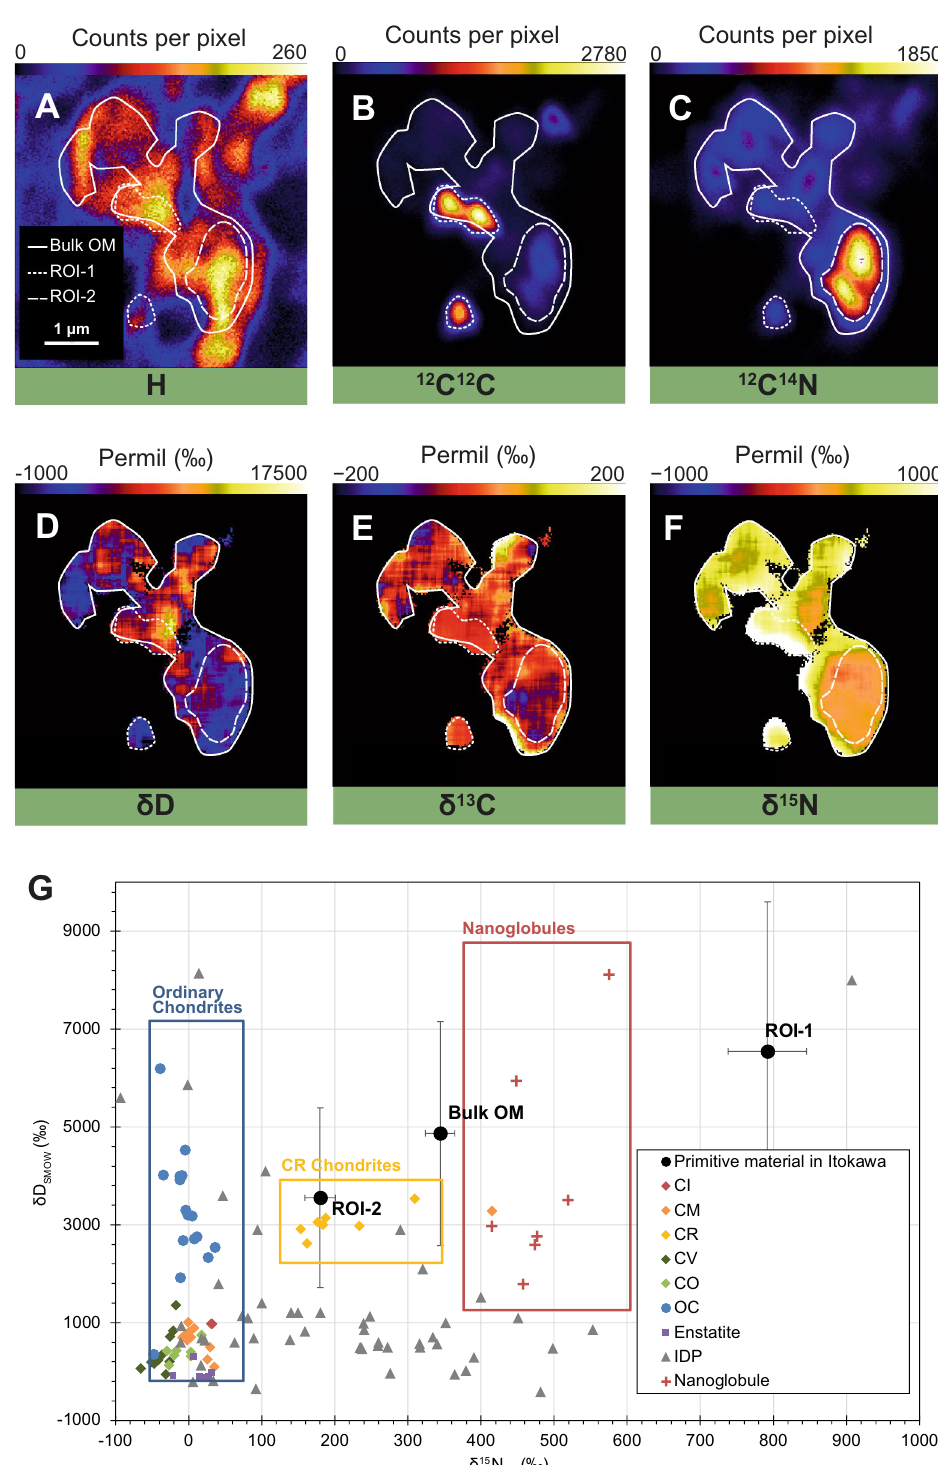
Figure 3. Isotopic composition of the primitive organic material in Amazon. ( A ) NanoSIMS ion image of H. ( B ) 12 C 12 C. ( C ) 12 C 14 N. ( D ) Isotopic images of the CN-rich region of δD, ( E ) δ 13 C and ( F ) δ 15 N. ( G ) Isotopic compositions for H versus N, for organic material in Amazon, various chondrites, interplanetary dust particles, and nanoglobules. The area marked as bulk OM was determined by CN enrichment in the 12 C 14 N ion image, and ROI-1 and ROI-2 by enrichments in C and N in the 12 C 12 C and 12 C 14 N ion images, respectively. The H and N isotopic compositions of Amazon OM suggest a genetic link between the primitive organic material observed in Itokawa to CRs and IDPs. Error bars are 2 sigma errors. All data and data sources are provided in the Supplementary Material (Table S5). The NanoSIMS ion and isotopic images were processed using the IDL (L3Harris Geospatial Solutions, Inc.) based L’image software package (Larry Nittler, Carnegie Institution of Washington, http:// limag esoft ware.